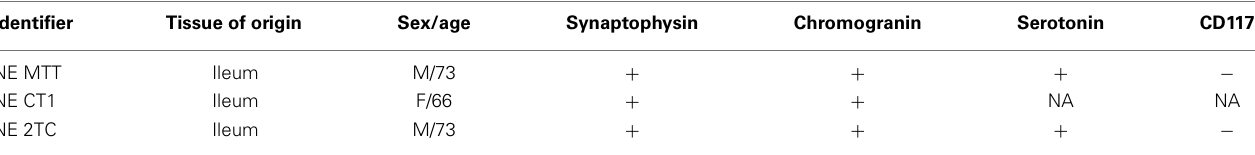
Table 1 | SI-NET biopsies.